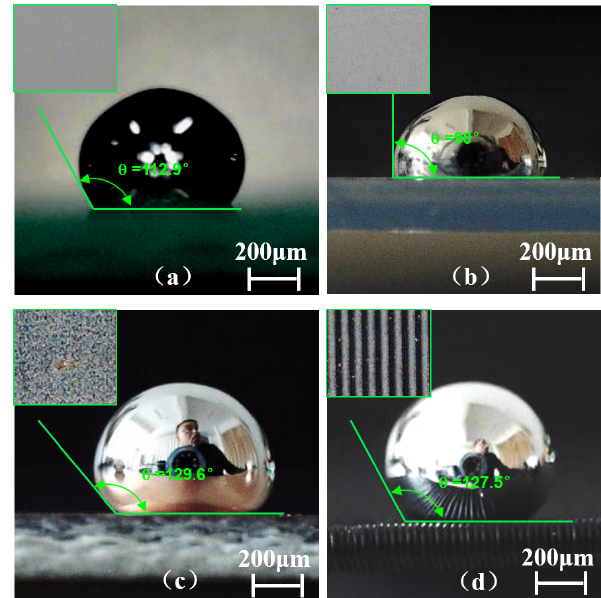
Figure 3. The morphologies of liquid metal on the surface of dif- ferent substrate materials: (a) glass; (b) PVC; (c) copper-clad plate; (d)